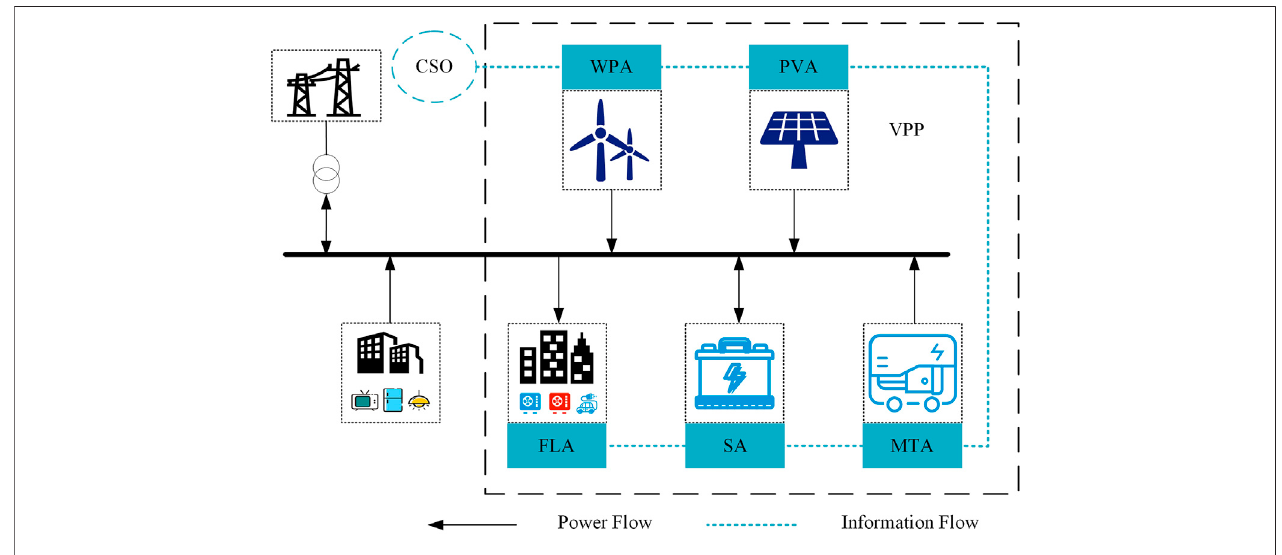
FIGURE 1 | VPP system schematic